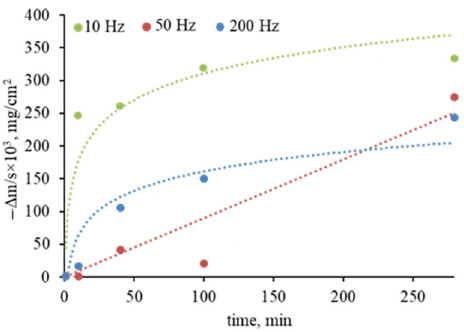
Figure 5. Changes in specific weight of the Mo-Zr-Si-B coatings deposited by HIPIMS onto an Al 2 O 3 substrate at frequencies of 10, 50, and 200 Hz as a function of time of annealing at 1000 °C.